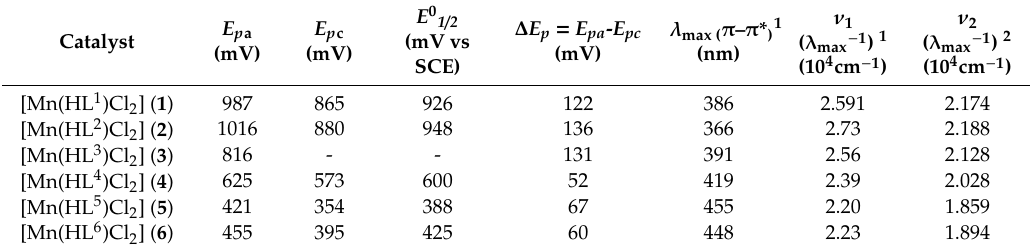
Table 1. Electrochemical and spectroscopic data for [Mn II (HL 1–6 )Cl 2 ]